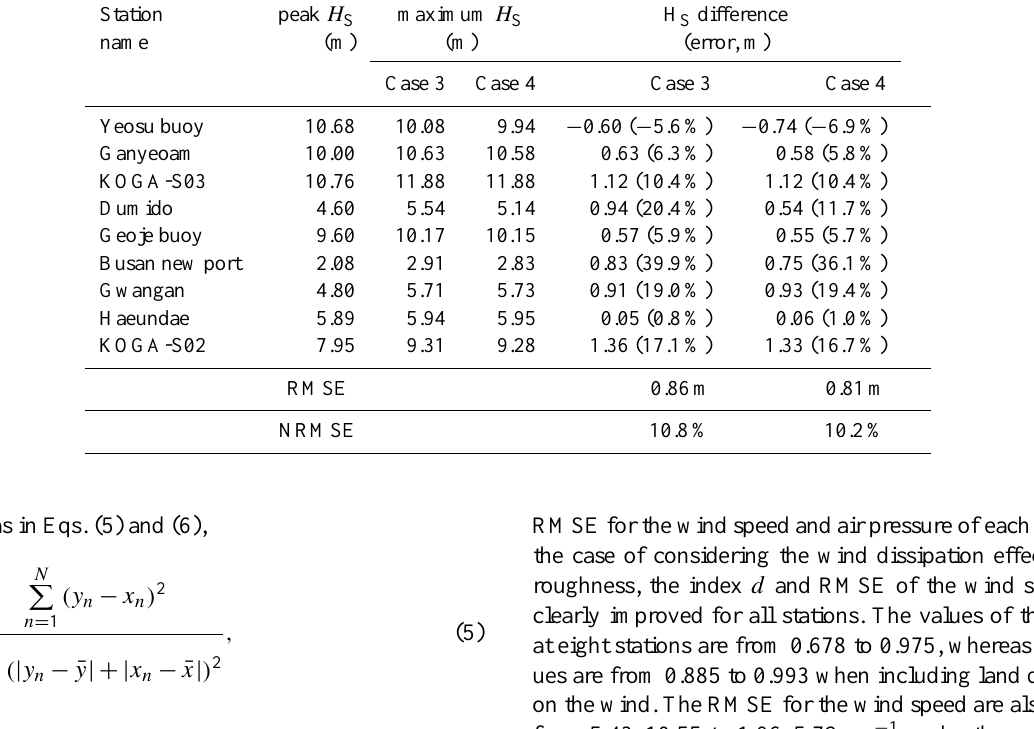
Table 5. Simulated and observed maximum H S for each scenario (see Figs. 4 and 9, and Table 1 for locations). Observed Simulated Maximum